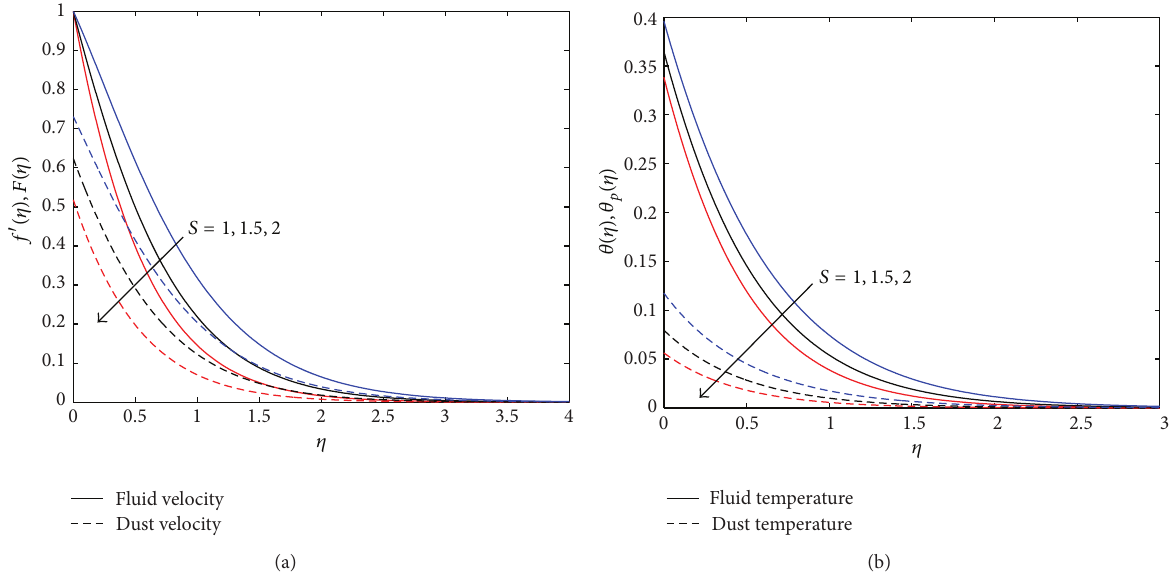
Figure 3: Effect of 𝑆 on (a) 𝑓 󸀠 , 𝐹 and (b) 𝜃 , 𝜃 𝑝 when 𝑀 = 1 , 𝛽 ℎ = 1 , 𝑁 = 1 , Bi = 1 , and Ec = 0.1